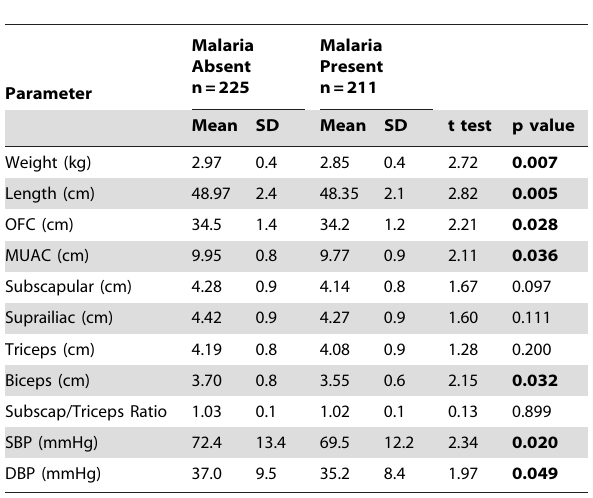
Table 2. Associations between maternal malarial status, newborn growth characteristics and newborn blood pressure at birth.